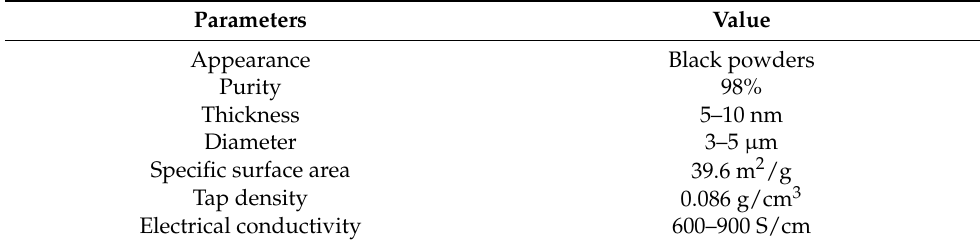
Table 1. Specific parameters of graphene oxide.